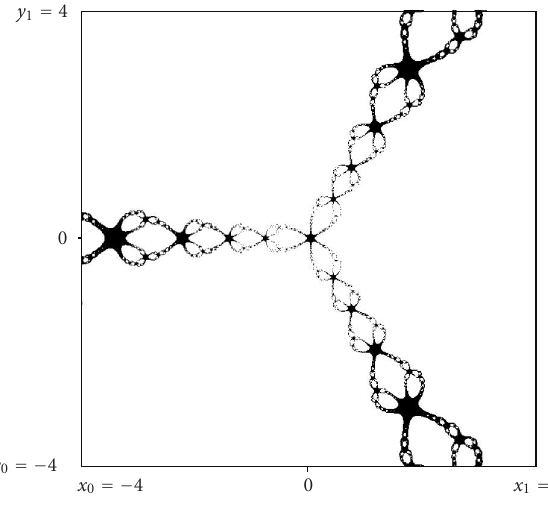
Figure 1.1. Basin boundaries are pictured of the three roots of